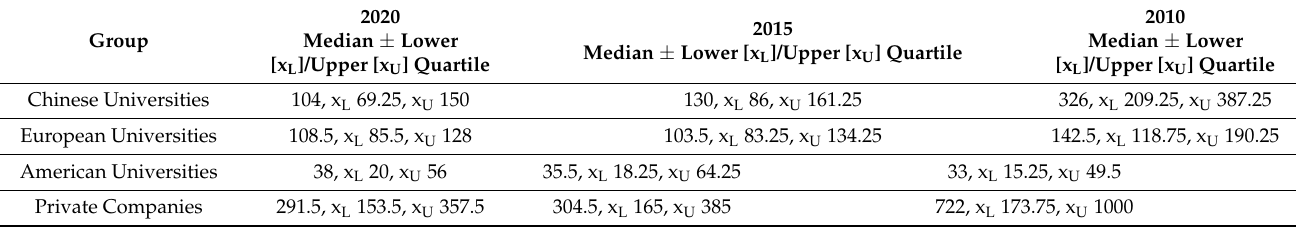
Table 3. Trends 2010–2020 in sub-indicator “Research” in the best 30 universities of China, the European Union, the US, and in private